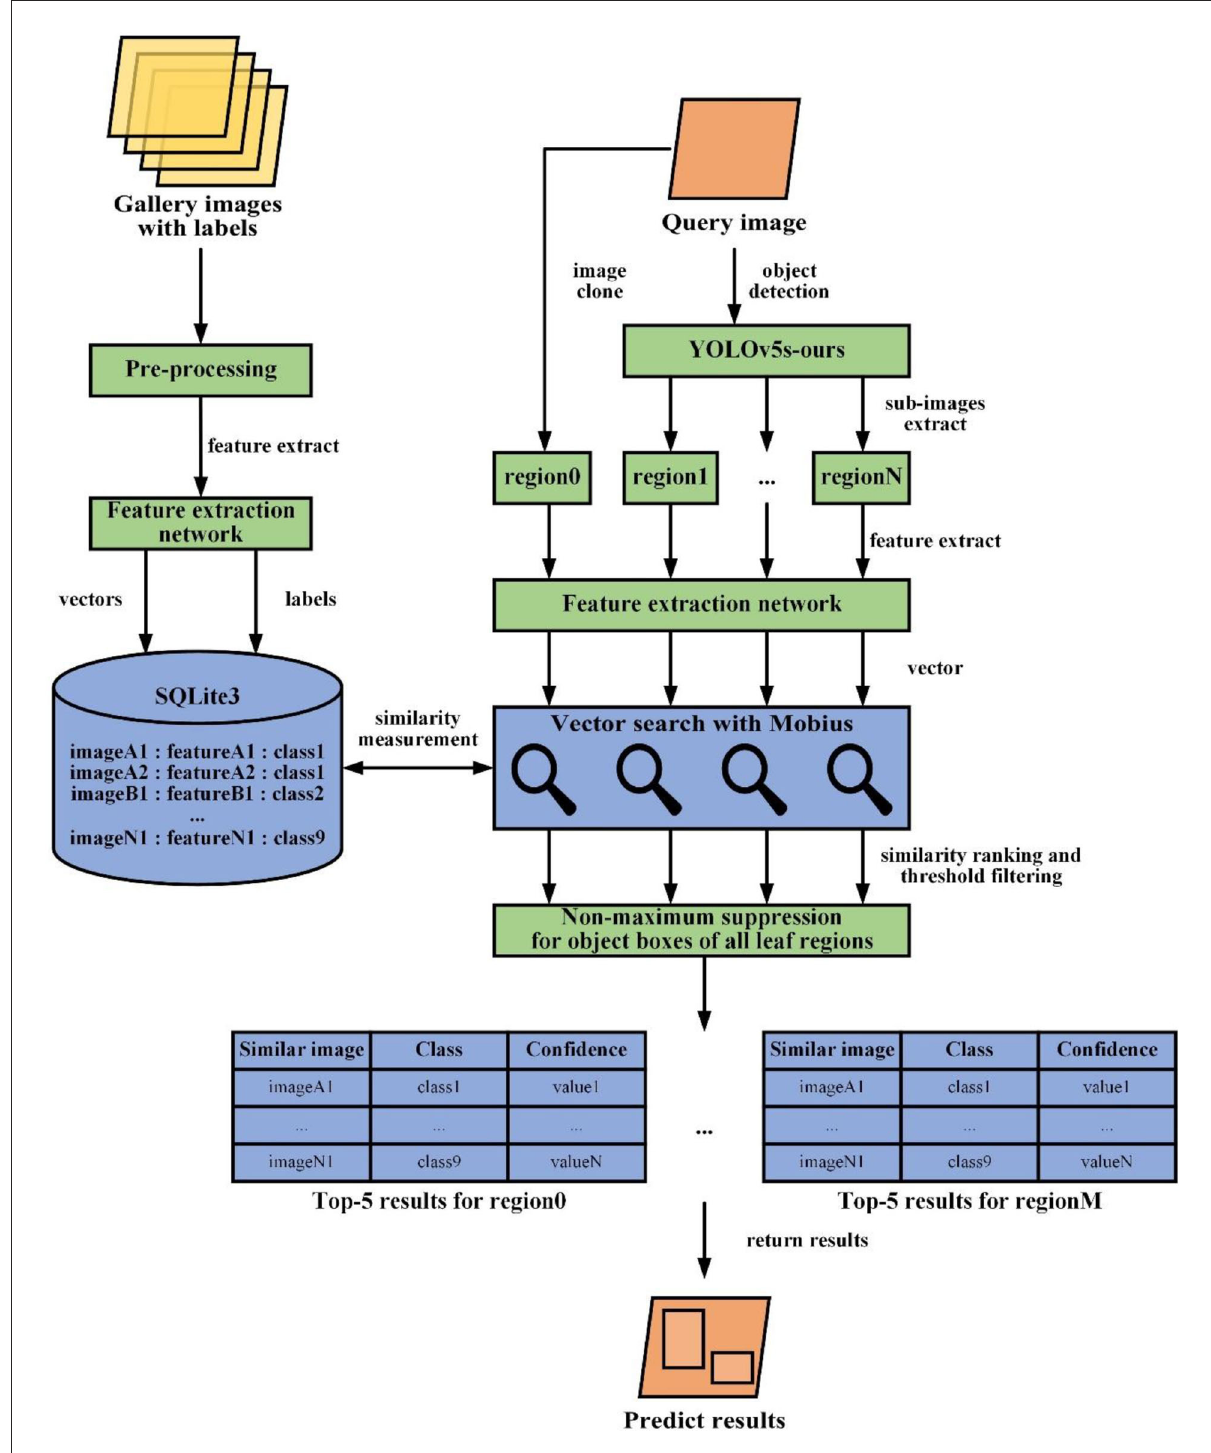
FIGURE7 Workflow of the proposed image retrieval